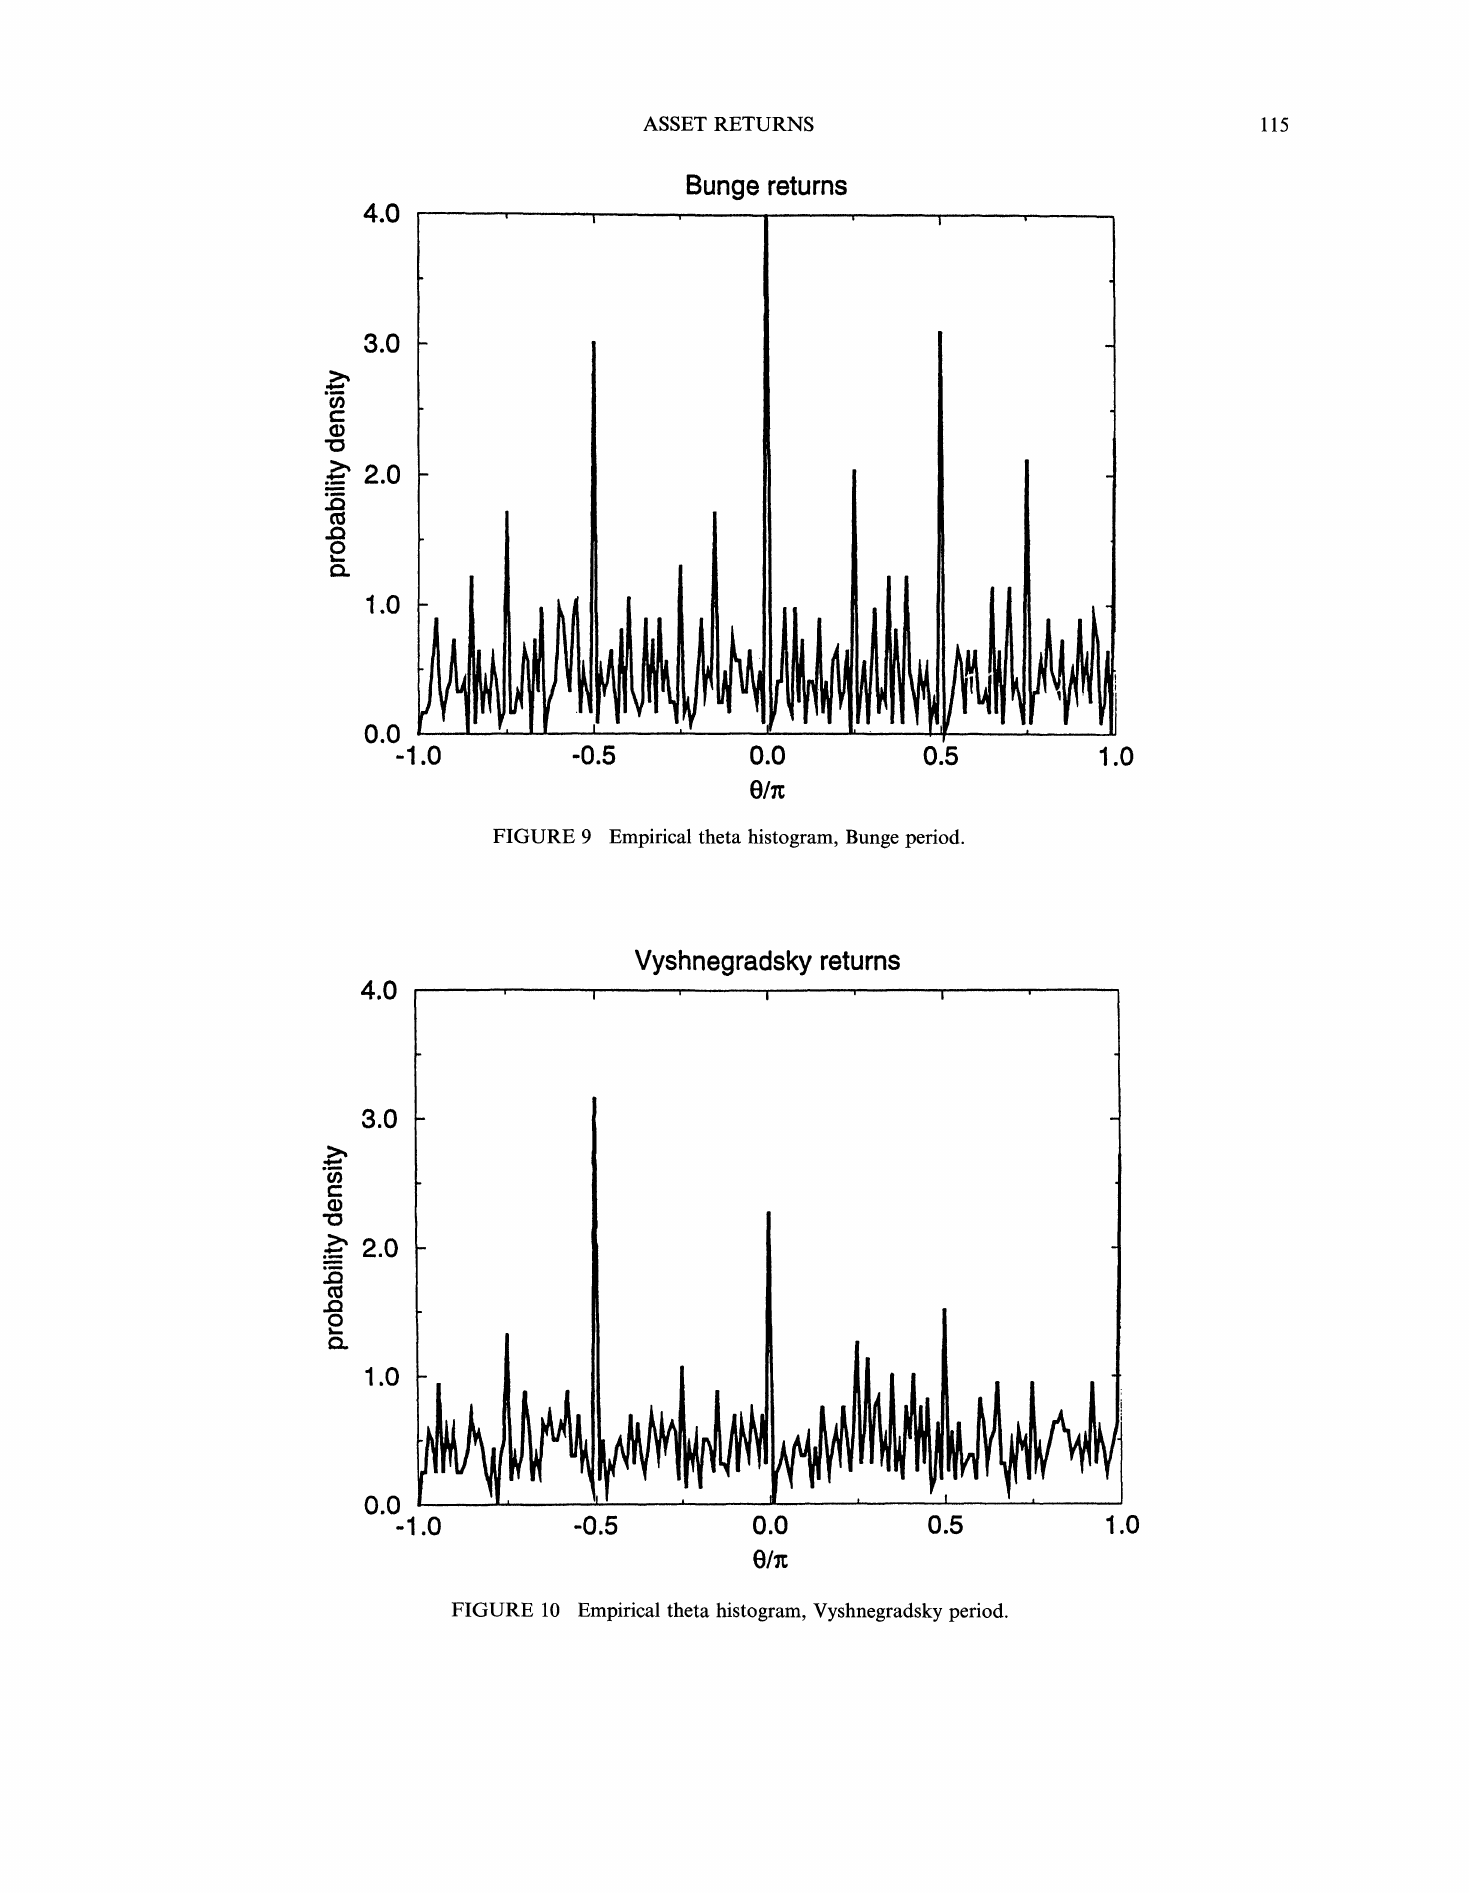
.0 FIGURE 10 Empirical theta histogram, Vyshnegradsky